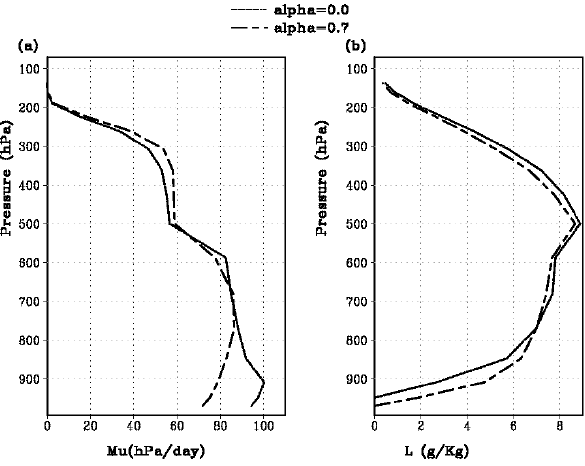
Fig. 5. Vertical profile of the area averaged (0 to 360 and 7 ◦ S to 7 ◦ N), time mean, quantities for α =0 and α =0.7 (a) Updraft mass flux (hPa/day), (b) cloud liquid water (g/kg).